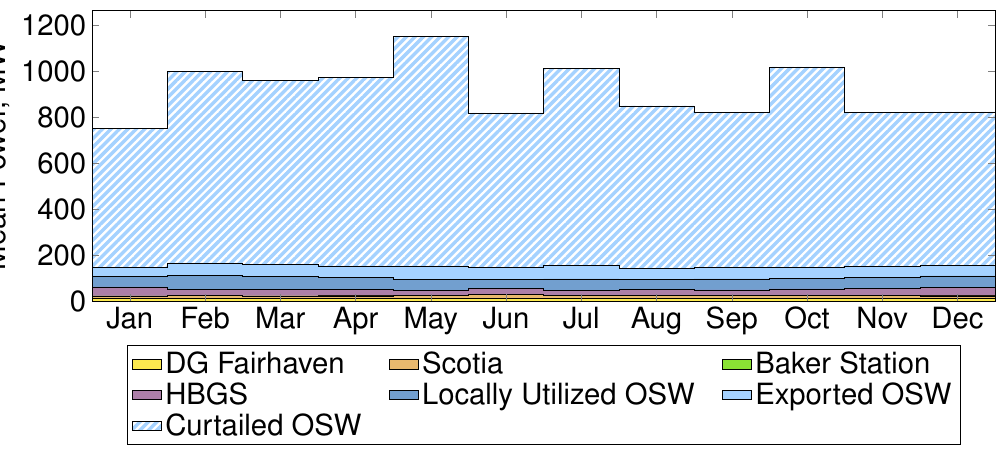
Figure 12. Hourly generation and load during three di ff erent wind speed regimes in February 2009 (vertical columns). The generation mix is shown for each day when adding 48 MW, 144 MW, and 1836 MW wind farms (horizontal rows). Note that the y -axis scale for the 1836-MW cases covers a much wider range of values than the y -axis scales for the 48 and 144-MW